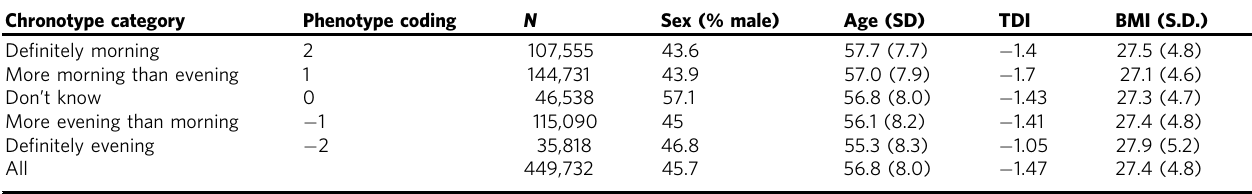
Table 1 Distribution and demographics of chronotype in the UK Biobank Chronotype category